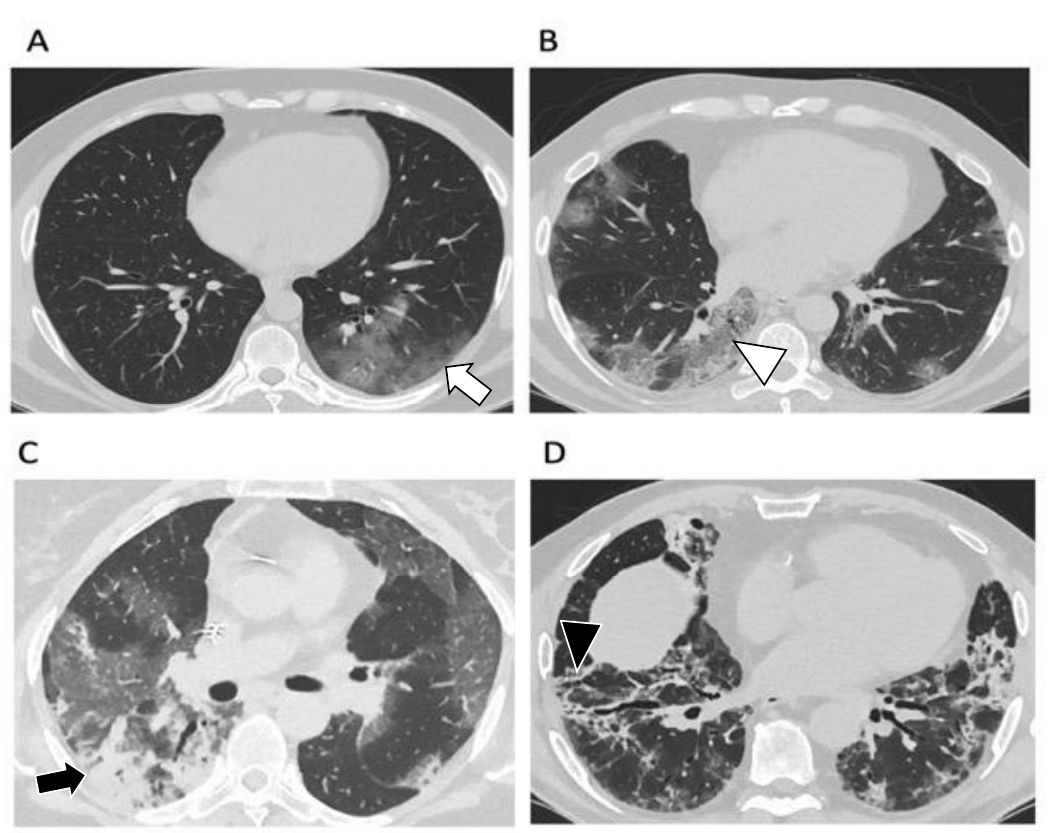
Figure 2. Axial chest CT images with windowing and leveling for the evaluation of lung parenchyma in patients affected by SARS-CoV-2 according to the different stages of the disease. ( A ). Early or initial stage (0–4 days): normal CT or sporadic ground-glass opacities (white arrow). ( B ). Progressive stage (5–8 days): ground-glass opacities are widely distributed, and crazy paving appearance can be evident (white arrowhead). ( C ). Peak stage (9–13 days): lung consolidations (black arrow) appear nearby the ground-glass opacities. ( D ). Absorption stage (>14 days): consolidations and ground-glass opacities slowly disappear while fibrotic findings can be evident, especially in the peripheral and lower zones (black arrowhead).